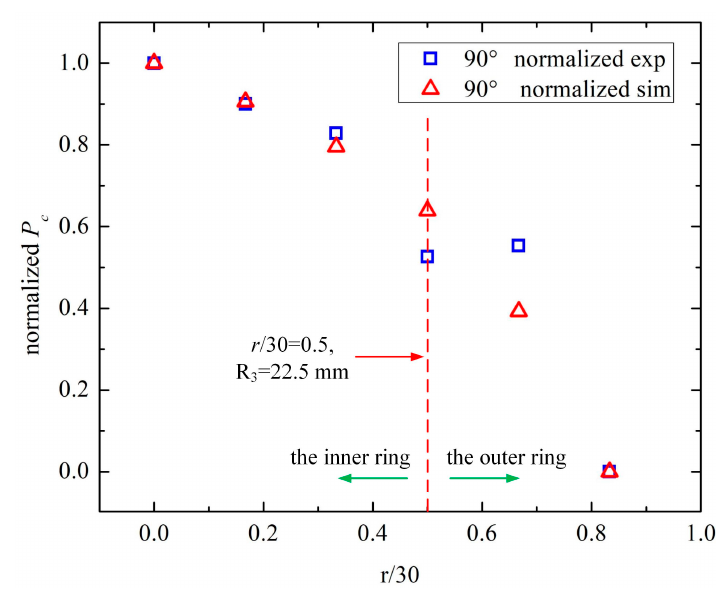
Figure 12. The normalized P c of the experiment and simulation.